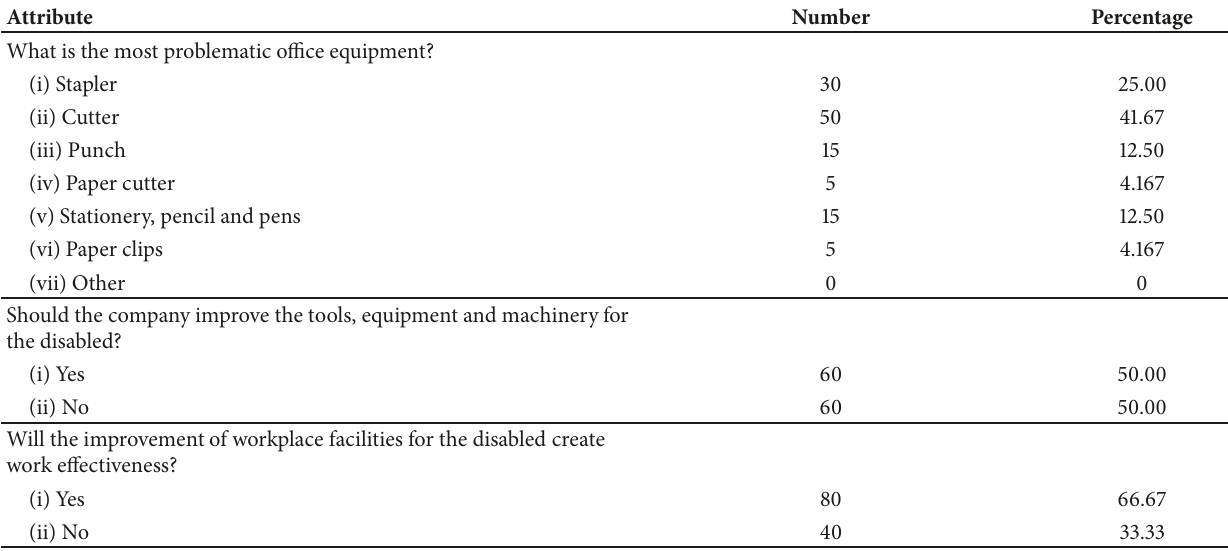
Figure 1: the researcher collected data in Phase 1 using ques- tionnaires, observations, and interviews with three